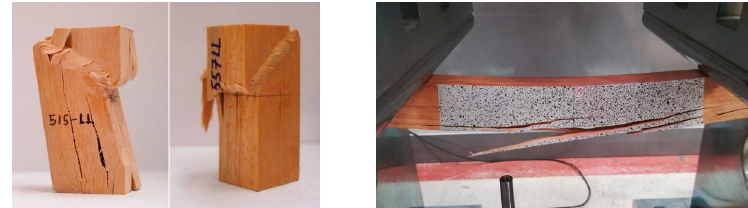
Figure 5. Typical failure modes in compression parallel to the grain ( left ); bending failure due to small grain deviation ( right ).